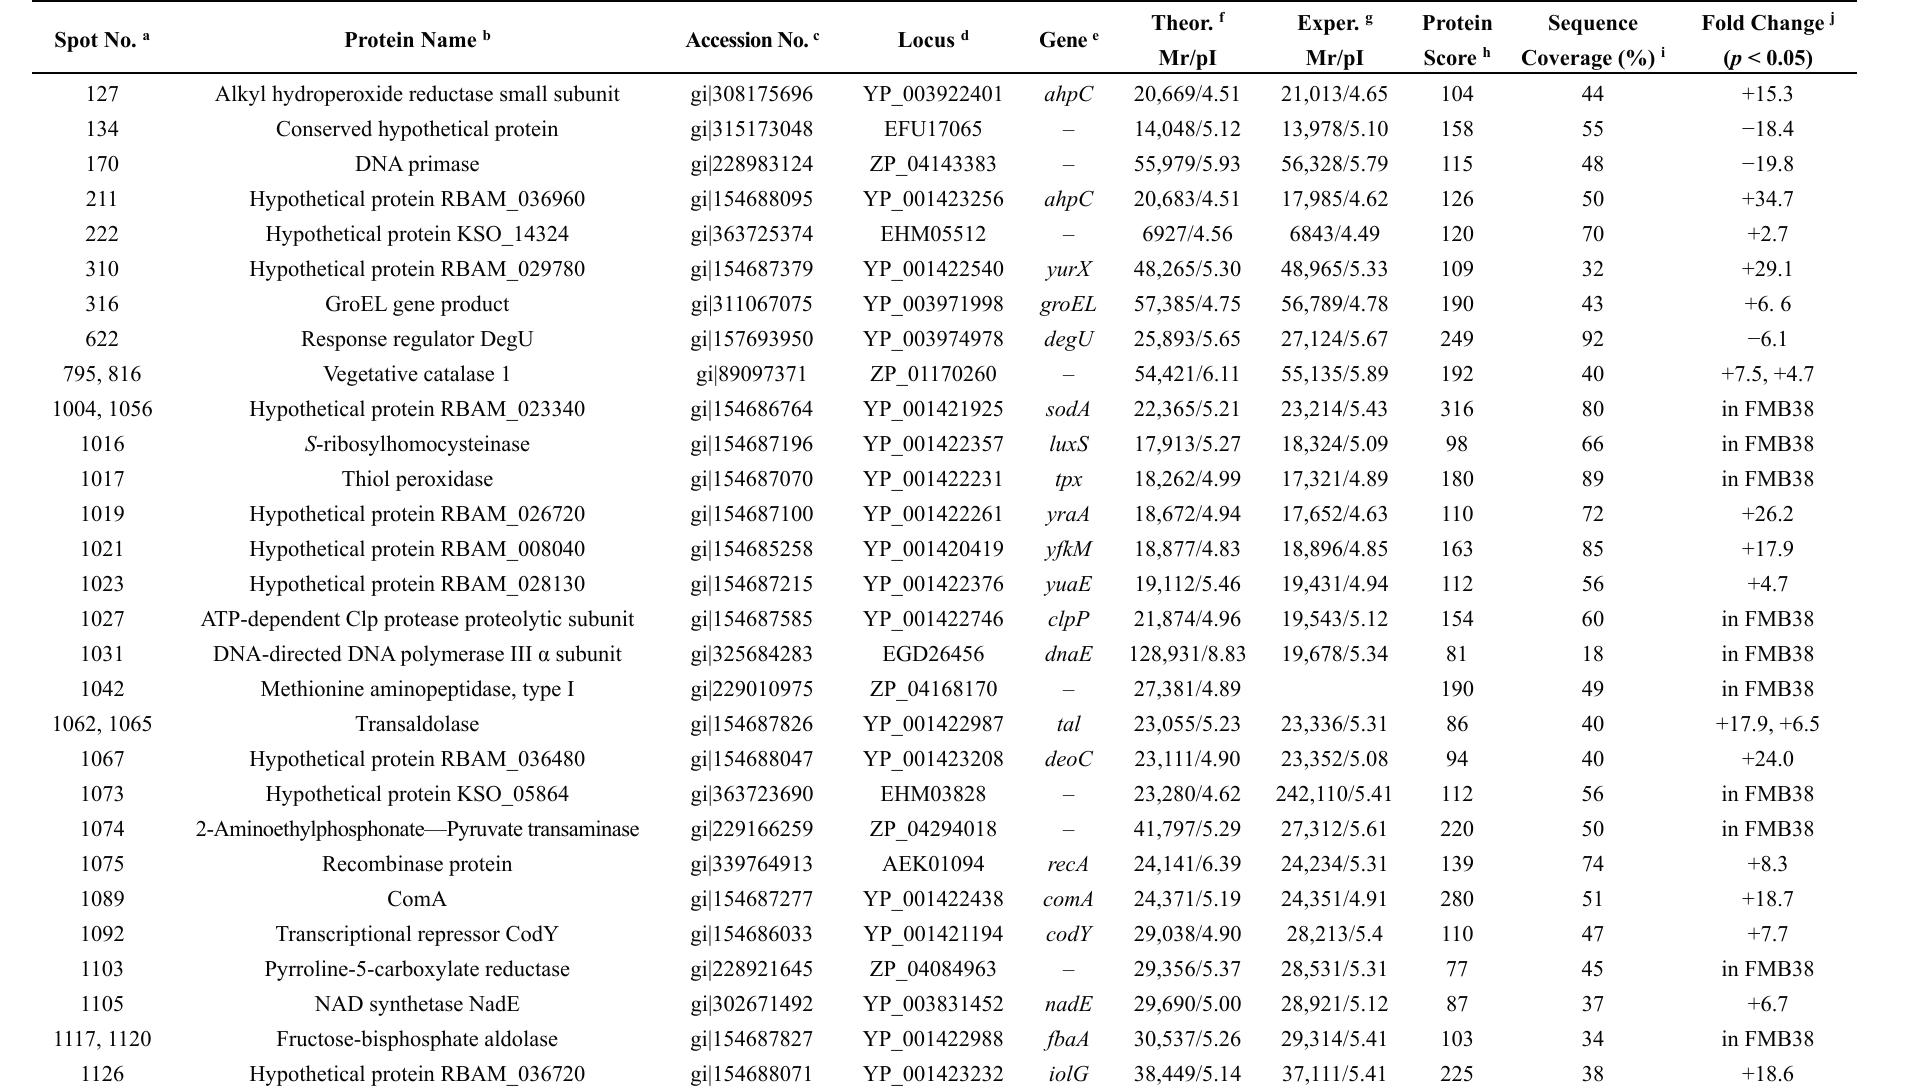
Table 1. Identification of differentially regulated cellular proteins (>2-fold change in expression) of Bacillus amyloliquefaciens FMB38. Spot No.